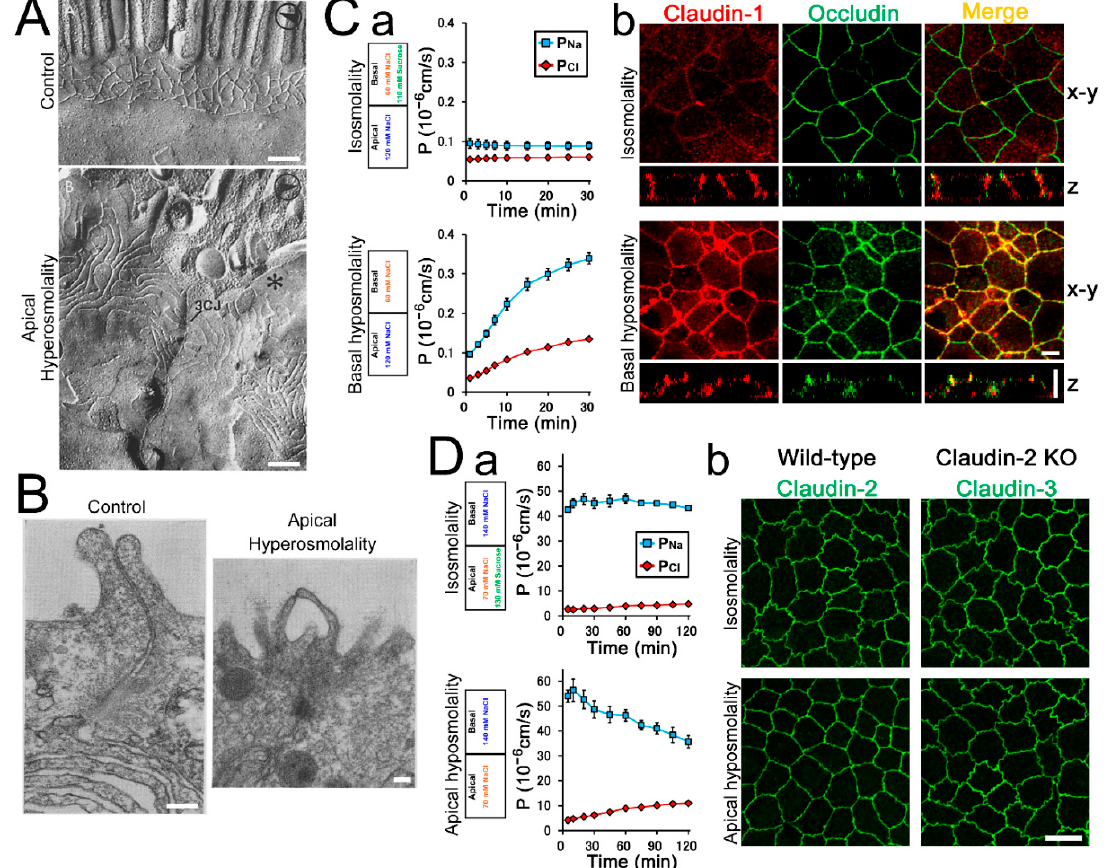
Figure 1. Effects of the osmotic gradient in various epithelia. ( A ) Freeze-fracture electron micrographs in the jejunal epithelium. Apical osmolality was increased to 600 mOsm with mannitol and cells were fixed 20 min after the osmotic changes. Apical hyperosmolality increased tight junction (TJ) strand number and depth. Scale bar = 200 nm. From Madara. J. Cell Biol. 1983 [11] with permission. ( B ) Transmission electron micrographs in the bladder epithelium. Apical osmolality was increased with 240 mM urea and cells were fixed 10 min after the osmotic changes. Apical hyperosmolality induced bleb formation between TJ strands. Scale bar = 200 nm. From Wade et al., Am. J. Physiol. 1973 [15]